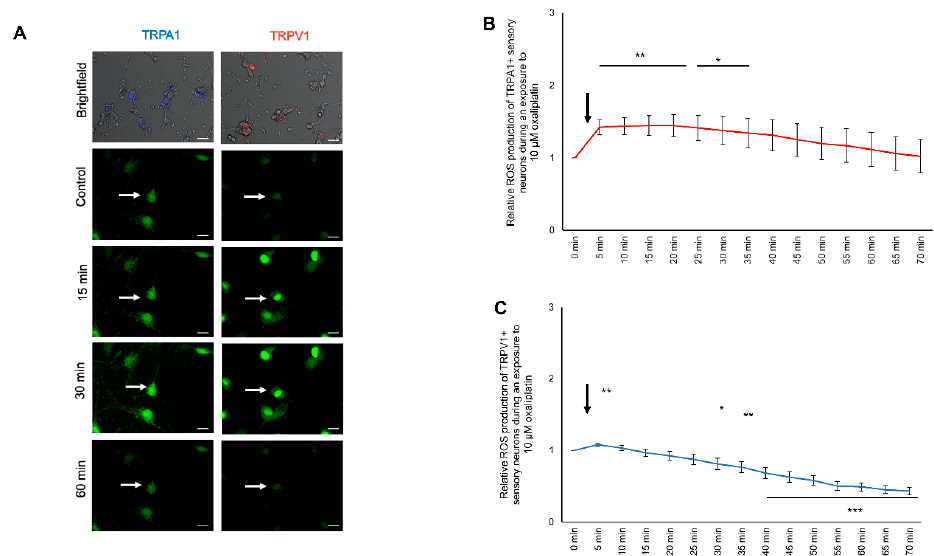
Figure 7. ROS production of TRPA1- or TRPV1-positive DRG neurons during exposure to 10 µM oxaliplatin. ( A ) Fluorescence of CellRox (green) of TRPA1- or TRPV1-positive DRG neurons at different time points. ( B ) The ROS production of TRPA1-positive DRG neurons increased after 5 min to 1.421 ± 0.103 (** p < 0.01) during exposure to 10 µM oxaliplatin and dropped to control level after 40 min at 1.31 ± 0.194 ( p > 0.05). ( C ) The TRPV1-positive sensory neurons had an increased ROS production after 5 min at 1.080 ± 0.020 (** p < 0.01) and dropped to the control level after 10 min at 1.033 ± 0.036 ( p > 0.05). After 30 min, the ROS production declined below the control level at 0.810 ± 0.079 (* p < 0.05) and steadily declined to 0.429 ± 0.050 after 70 min (*** p < 0.001). n = 6 cells per condition. * = significant effect compared to control level. Scale = 20 µm.